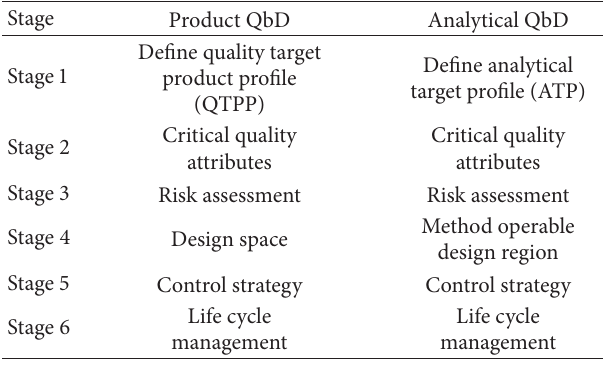
Table 1: Regulatory perspective; product QbD versus analytical